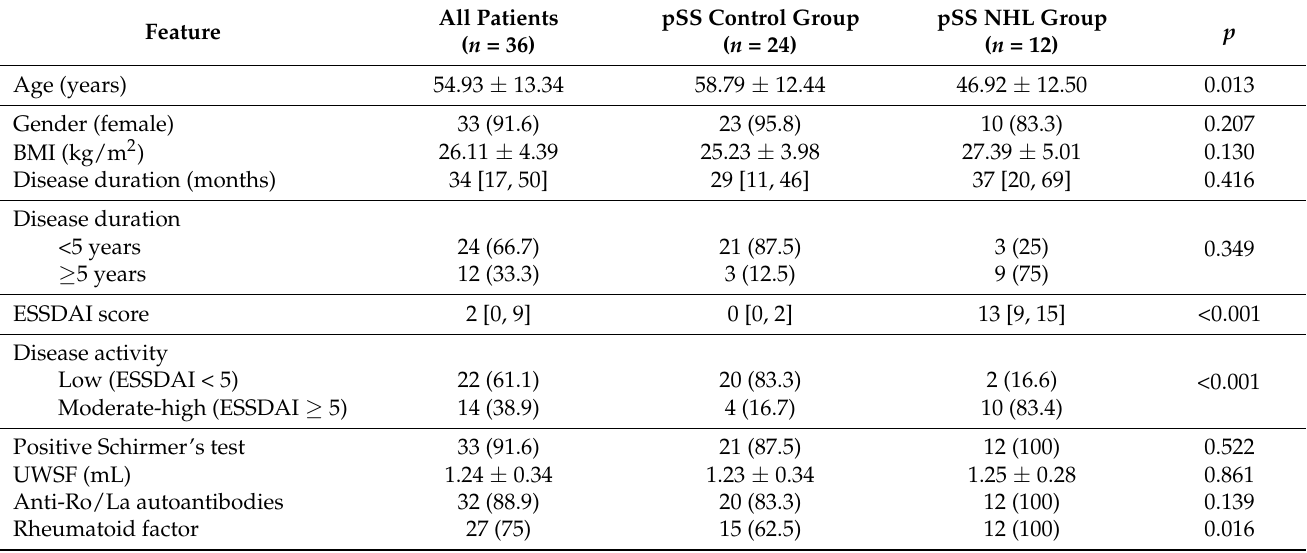
Table 2. Patient clinicobiological